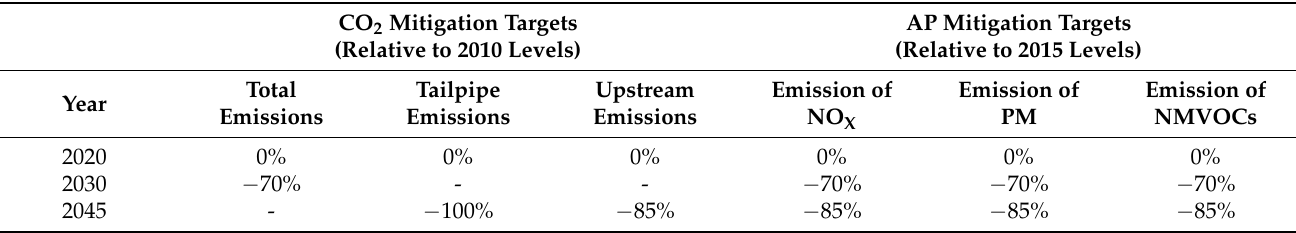
Table 2. Summary of CO 2 and air-pollutant mitigation targets and milestone